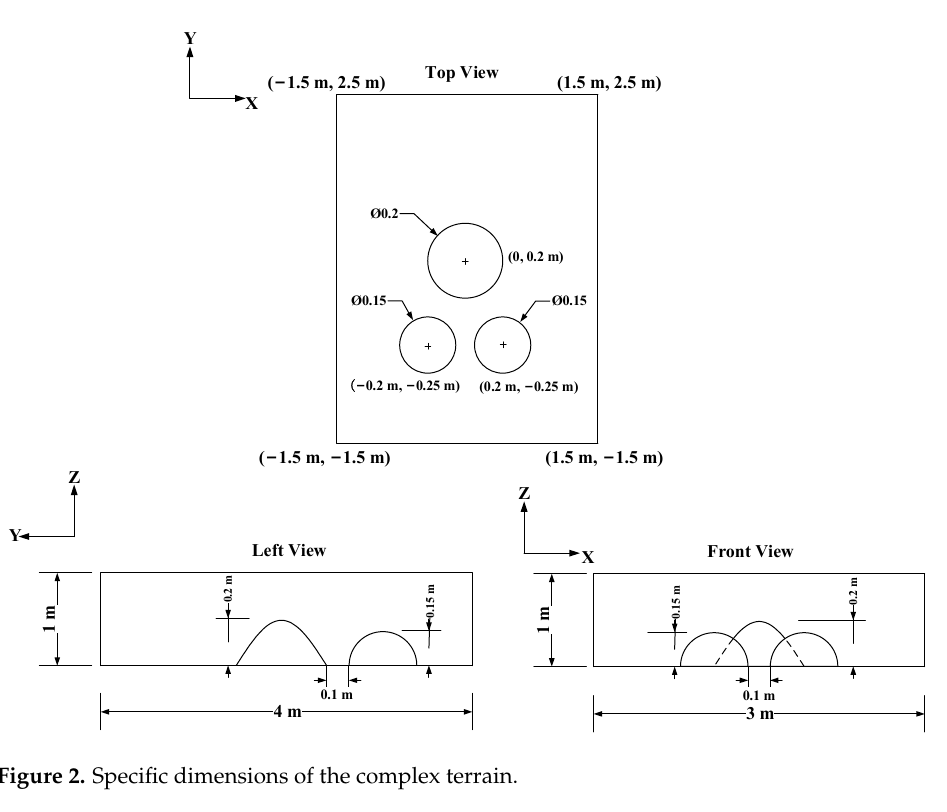
Figure 1. Geometric model for simulated wind field.